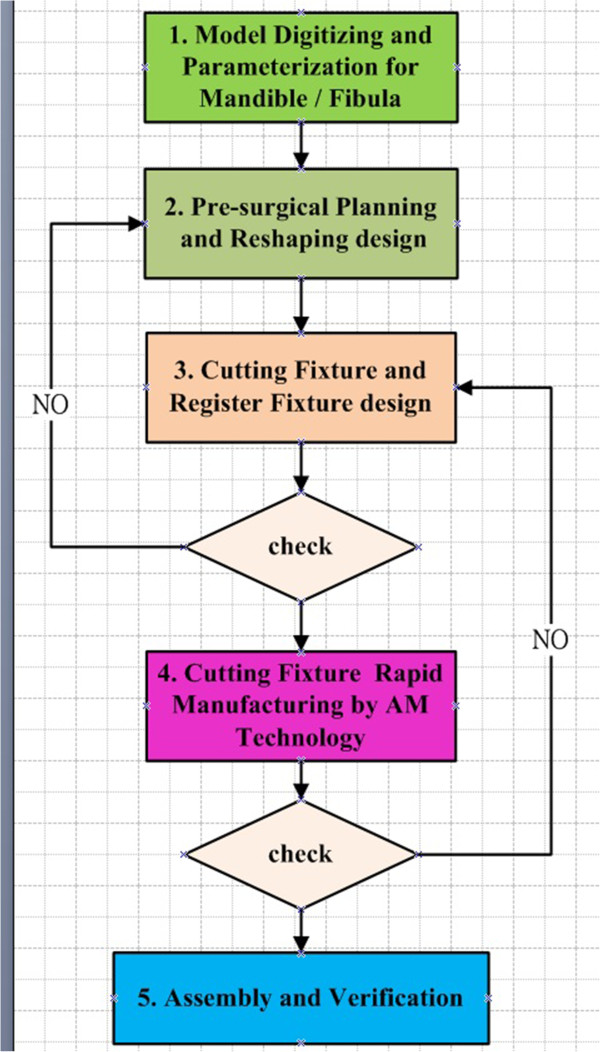
Study flowchart.